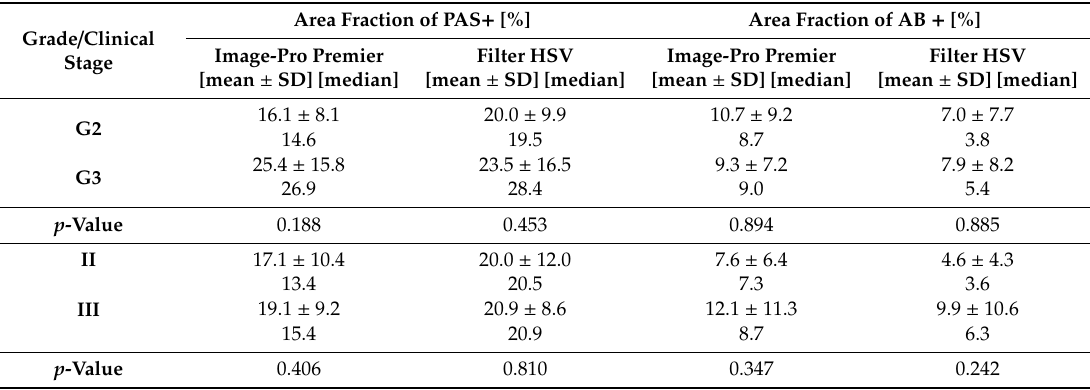
Table 5. Tissue expression of PAS + and AB + polysaccharides in colorectal carcinoma as related to grading (G2 vs. G3) and TNM clinical staging according to the AJCC / UICC (II vs. III). Grade /